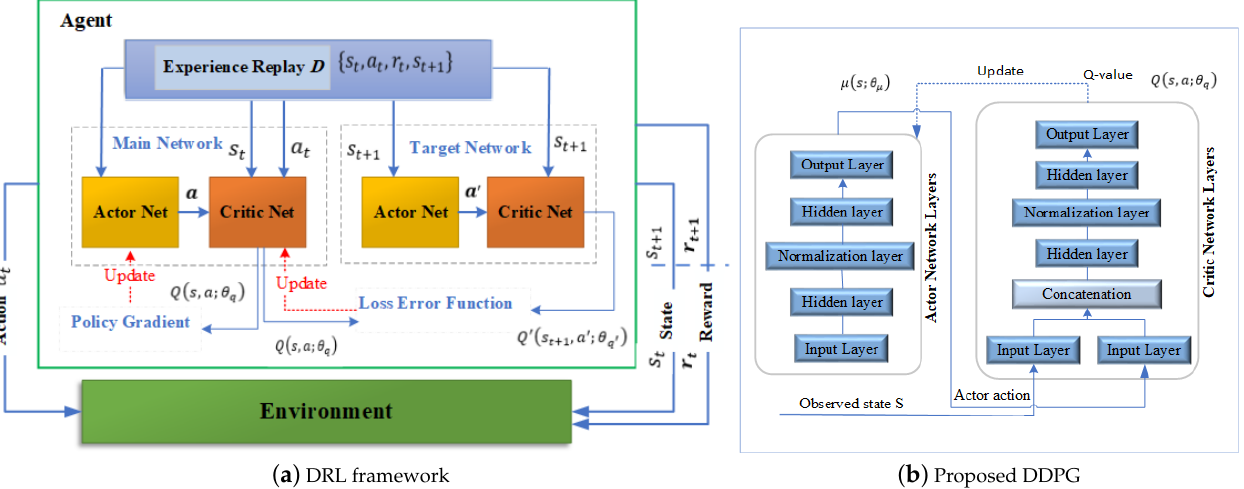
Figure 3. Designed model-based framework: ( a ) DRL framework with DDPG agent; ( b ) proposed DDPG actor–critic